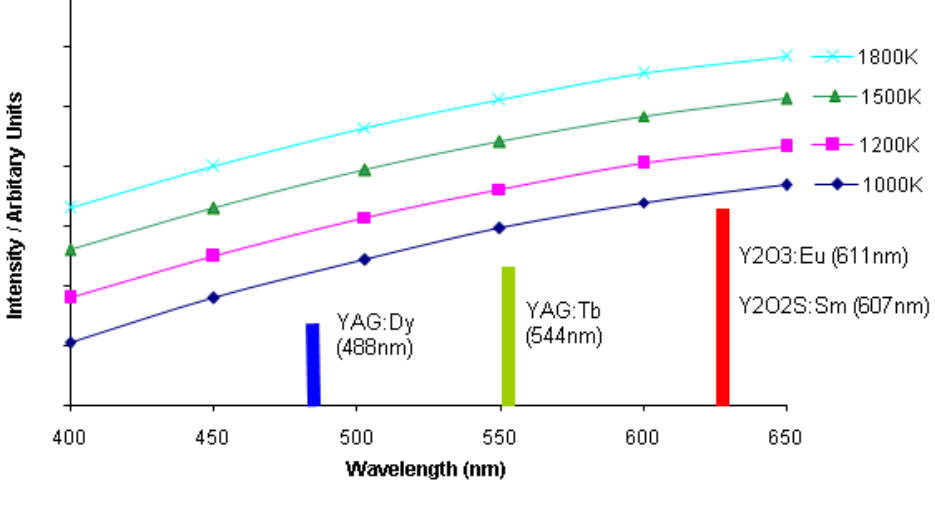
Figure 33. Phosphor intensity (at their peak emission wavelengths) required to maintain similar signal to blackbody